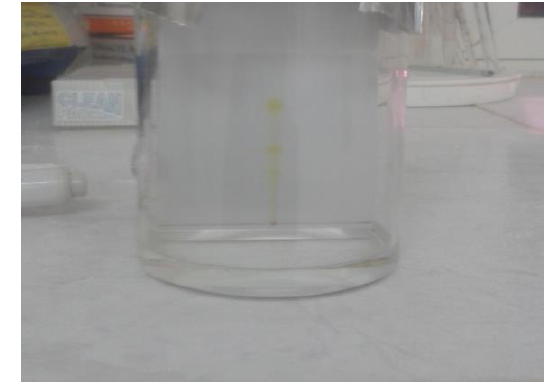
Figure 4: TLC of curcumin